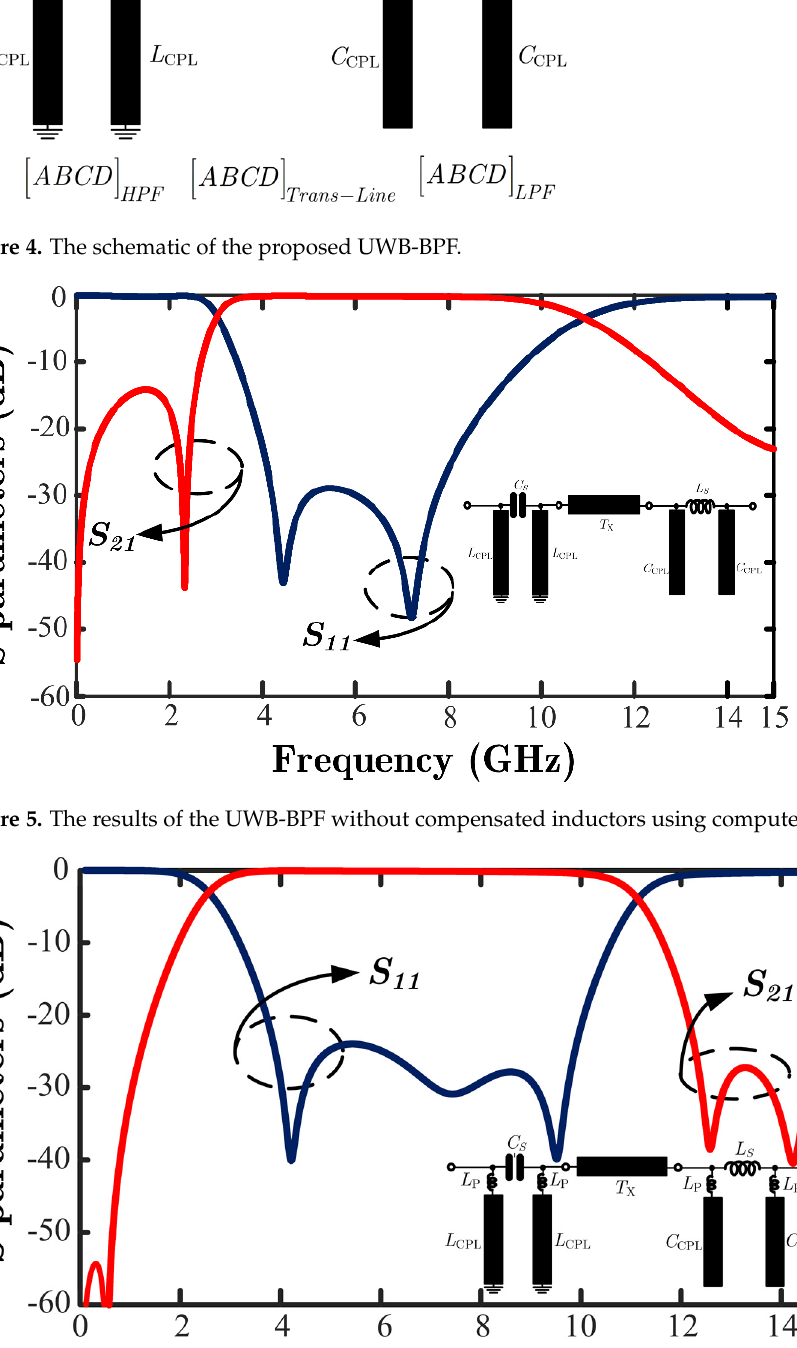
Figure 4. The schematic of the proposed UWB-BPF.